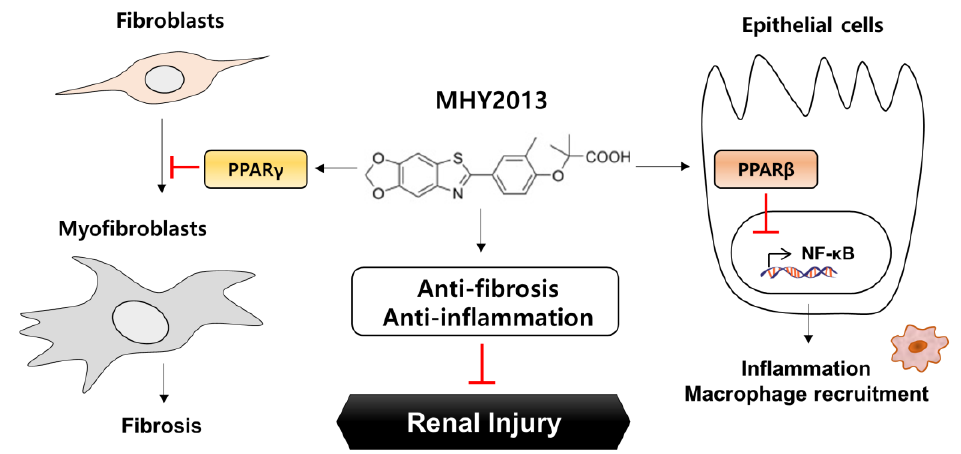
Figure 7. MHY2013 alleviates renal fibrosis in a mouse model by reducing fibroblast activation and epithelial inflammation.